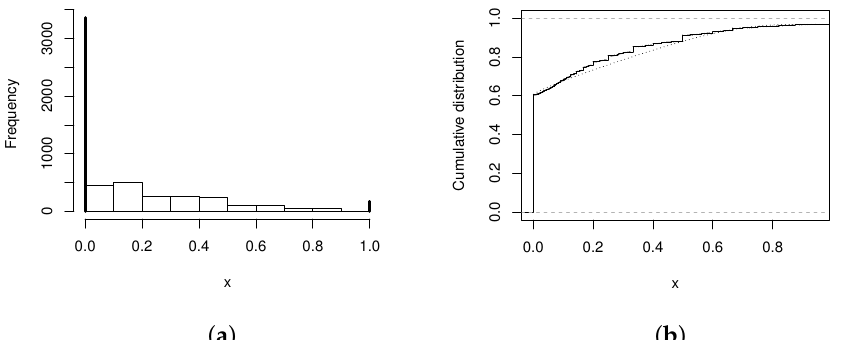
Figure 1. ( a ) Histogram of the death proportions. ( b ) Graphs: empiric (solid line), BUBSZOI model (dotted line).